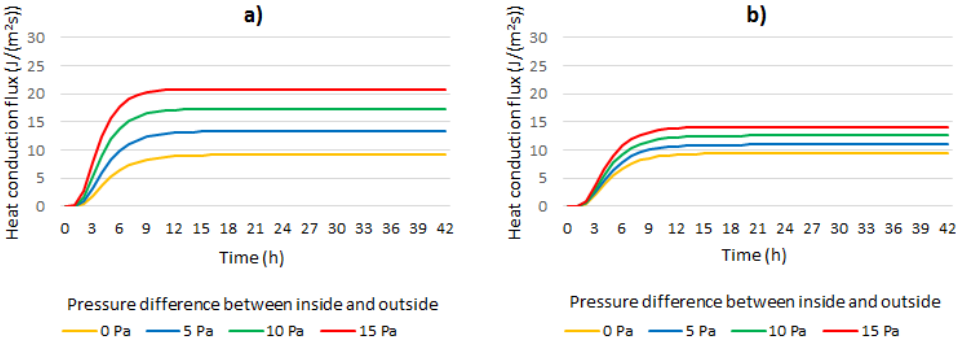
Figure 10. Heat conduction flux through the wall with 100 mm thickness of hemp fiber insulation with density of: 110 kg/m 3 ( a ) and 120 kg/m 3 ( b ) .